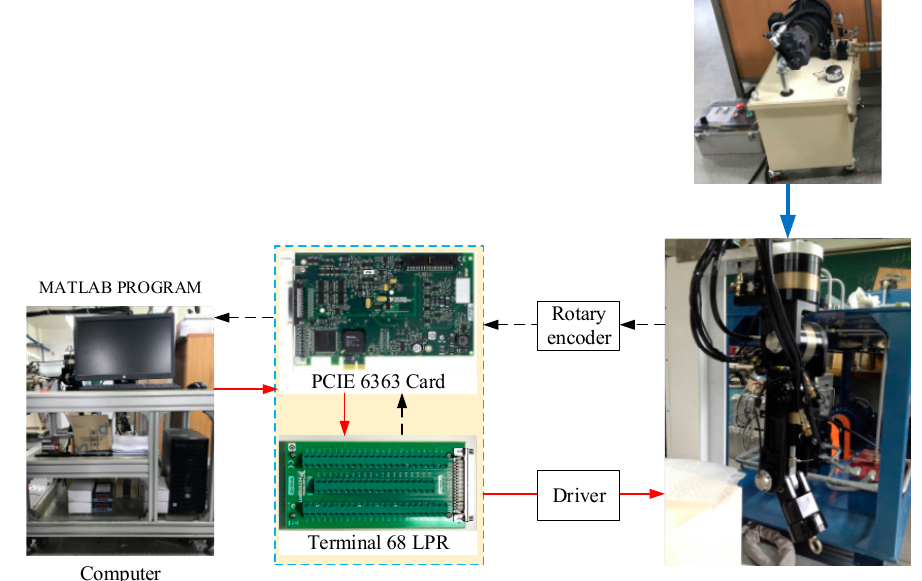
Figure 11. The hardware setup for the 3-DOF manipulator.